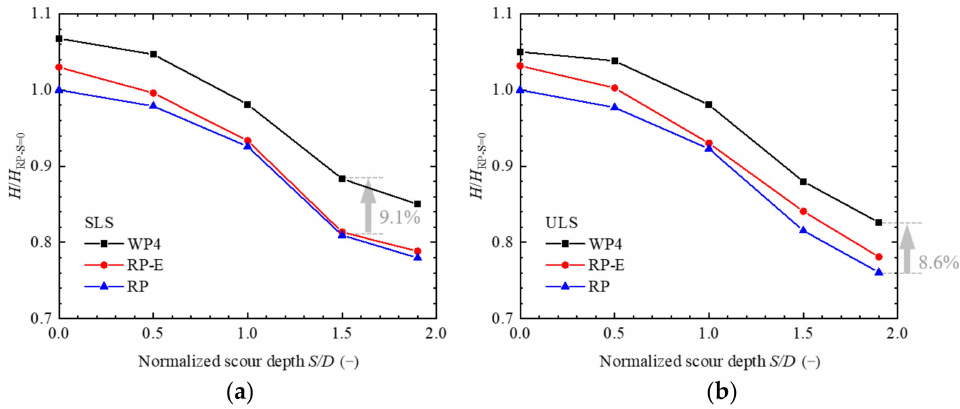
Figure 13. Variation in the ratio of lateral loads of WP4 and RP-E with scour depths at ( a ) SLS and ( b )